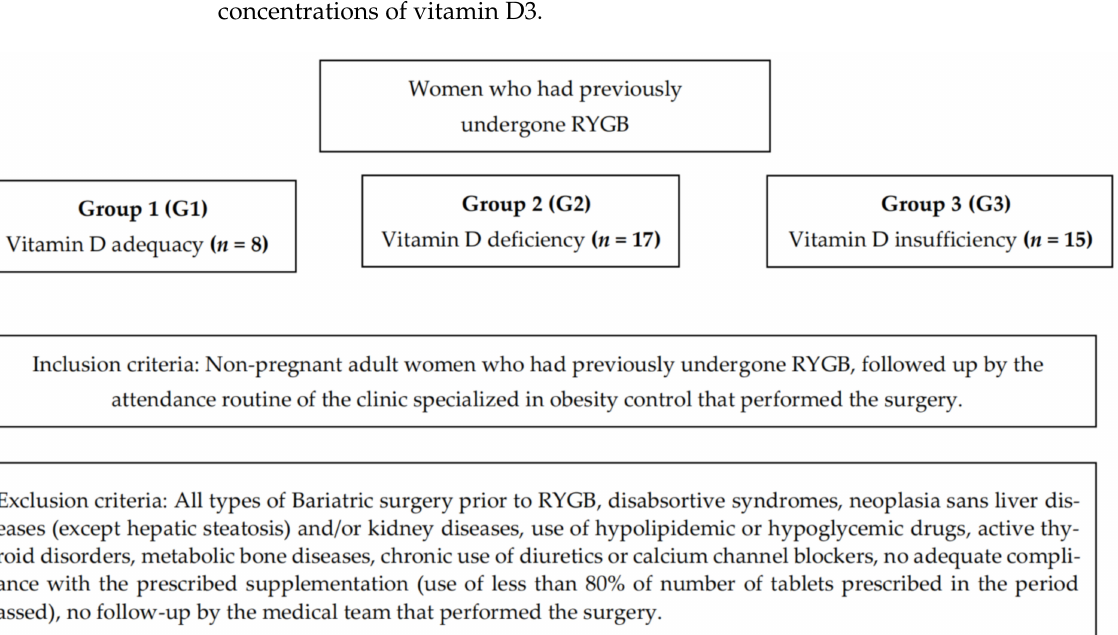
Figure 1. Description of the subdivision of groups and inclusion/exclusion criteria. G1: women with adequacy in the pre-operative nutritional status of Vitamin D; G2: women with deficiency in the pre-operative nutritional status of Vitamin D; G3: women with insufficiency in the pre-operative nutritional status of Vitamin